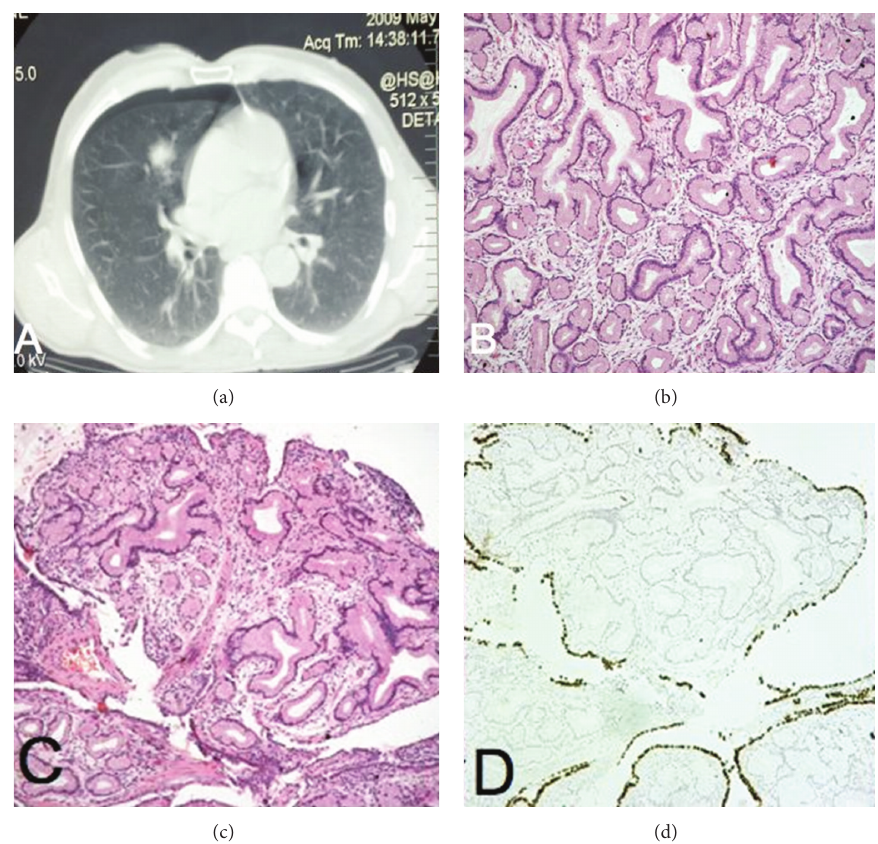
Figure 1: (a) Chest computed tomography during transthoracic needle biopsy, showing a parenchymal lesion of the middle lobe. (b) Mucus gland adenoma (H&E, × 200). (c) and (d) H&E and TTF-1 staining of the adenoma ( ×